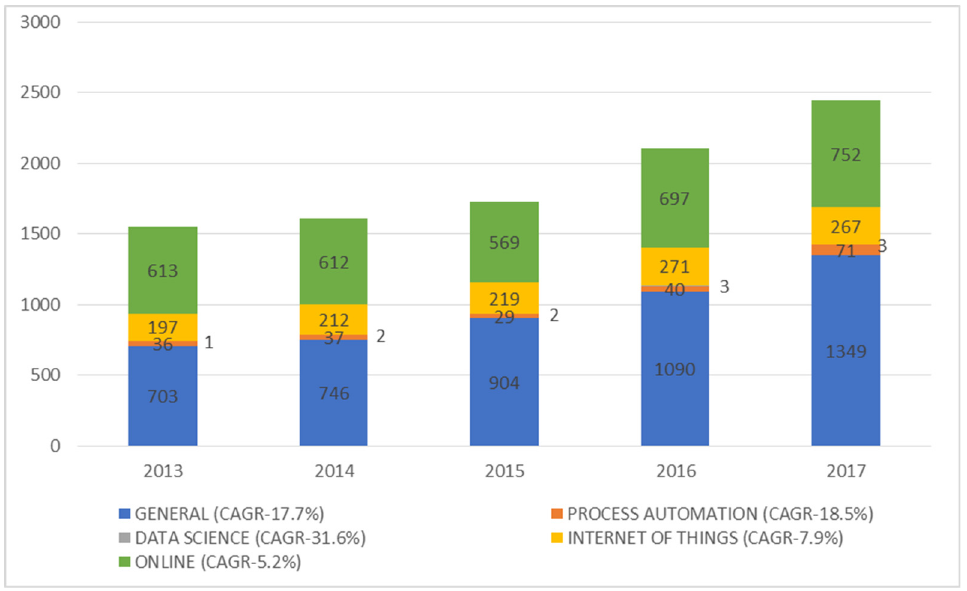
Figure 2. Digital maturity of Baltic companies (frequency of mentioned concepts in annual reports).